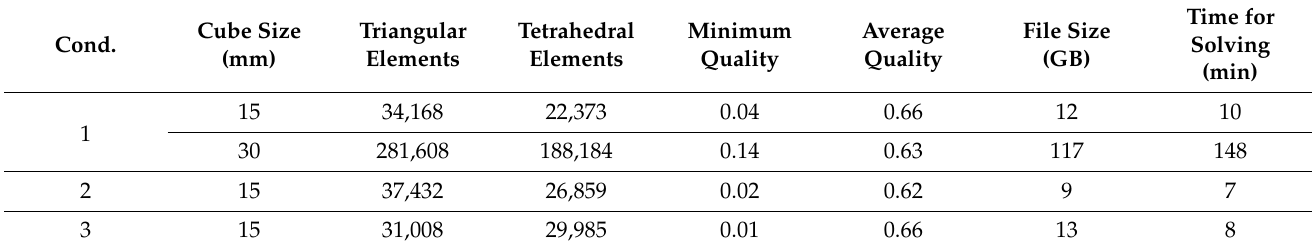
Table 3. Surface and volumetric mesh description, with resulting quality, file size and time for solving.